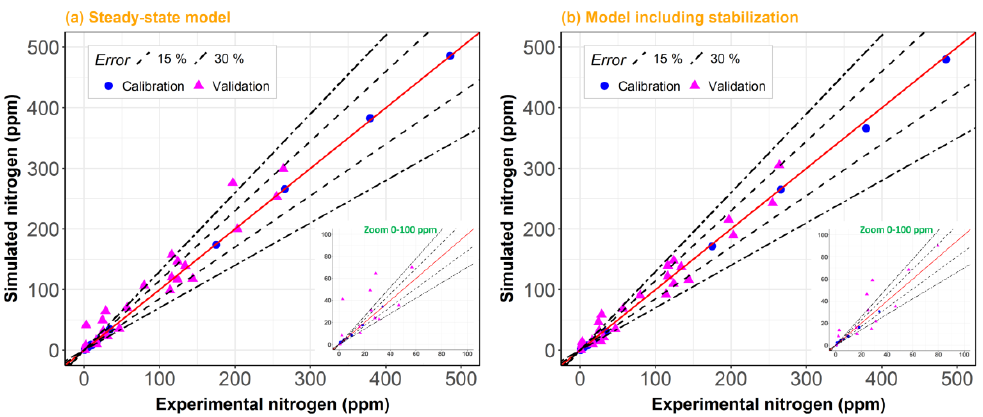
Figure 3. Parity plot of steady-state model ( a ) (RMSE = 20.09) and model including stabilization ( b ) (RMSE = 14.07) for the case with the calibration database containing 14 episodes selected by the Kennard–Stone technique.